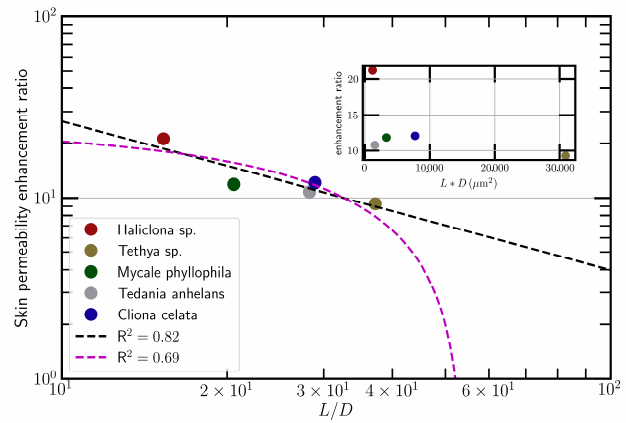
Figure 2. The correlation between the skin permeability enhancement ratio ( ER ) and the aspect ratio of spicules ( L/D ). Both linear and power-law fittings are shown as purple and black dash lines, with an R 2 of 0.69 and 0.82, respectively.